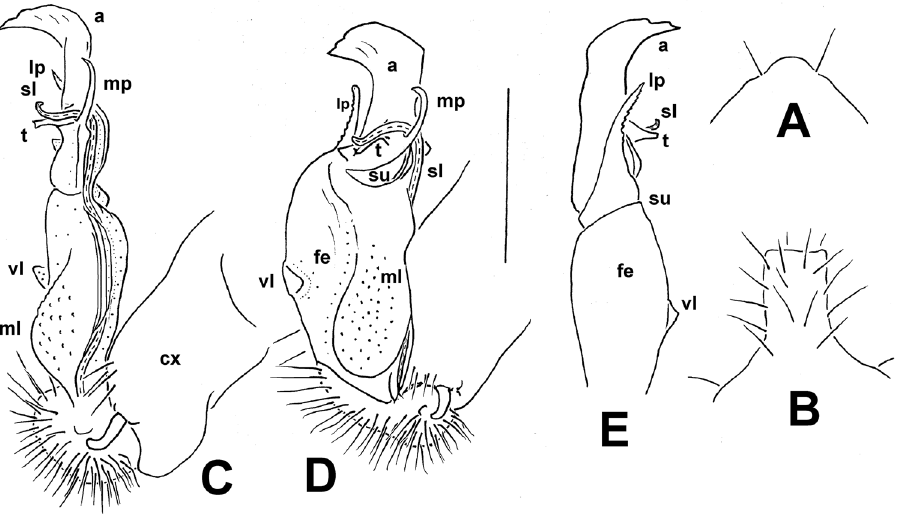
Figure 11. Annamina mikhaljovae sp. n., ♂ holotype (ZMUM). A hypoproct, ventral view B ster- nal lobe between coxae 4 C–E right gonopod, A mesal, B subventral and C lateral views, respectively (cx = coxite; fe = femorite, vl = ventral lobe; ml = mesal lobe; su = postfemoral sulcus; lp = lateral process; mp = mesal process; a = apical process; sl = solenomere; t = solenophore tooth). Scale bar 0.5